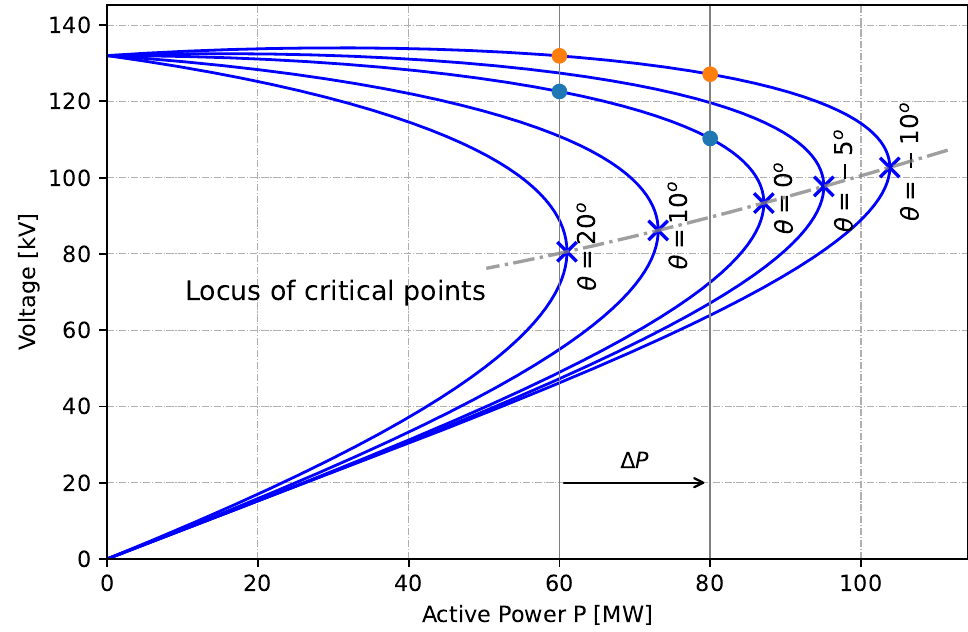
Figure 3. PV curves for multiple power factors.